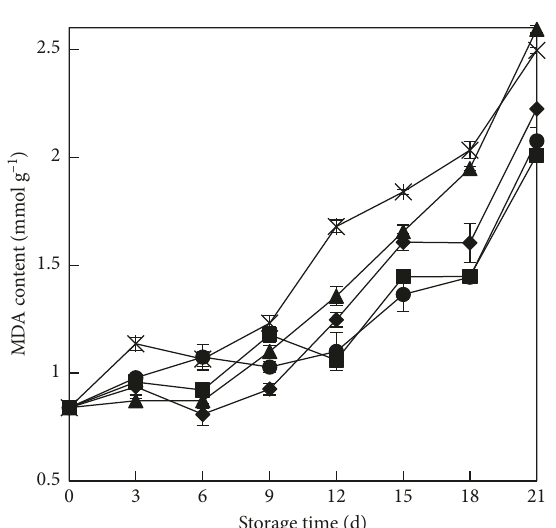
Figure 3: Effects of 1-MCP treatment on MDA content of yardlong bean during storage at 8 ° C. Each data pointis theaverage of nine fruits. Error bars represent the standard error of the means. Control ( ✲ ), 0.75 μ L · L − 1 ( ■ ), 1.0 μ L · L − 1 ( • ), 1.25 μ L · L − 1 ( ◆ ), and 1.5 μ L · L − 1 ( ▲ ).